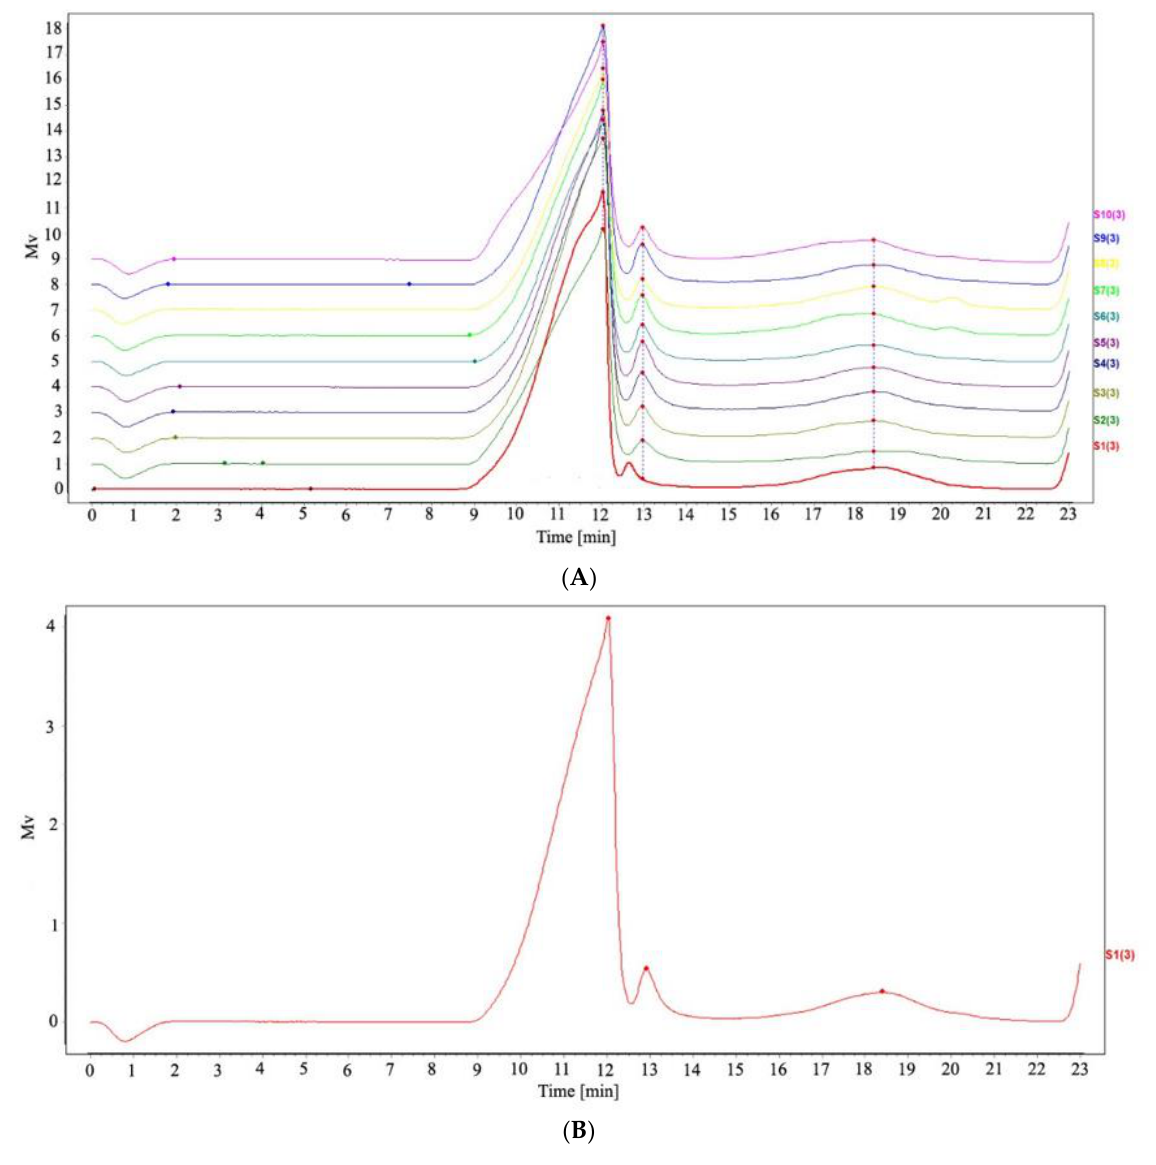
Figure 3. The HPSEC fingerprints. ( A ) the HPSEC fingerprints of different SPs ( B ) the HPSEC standard referential fingerprint of SPs.